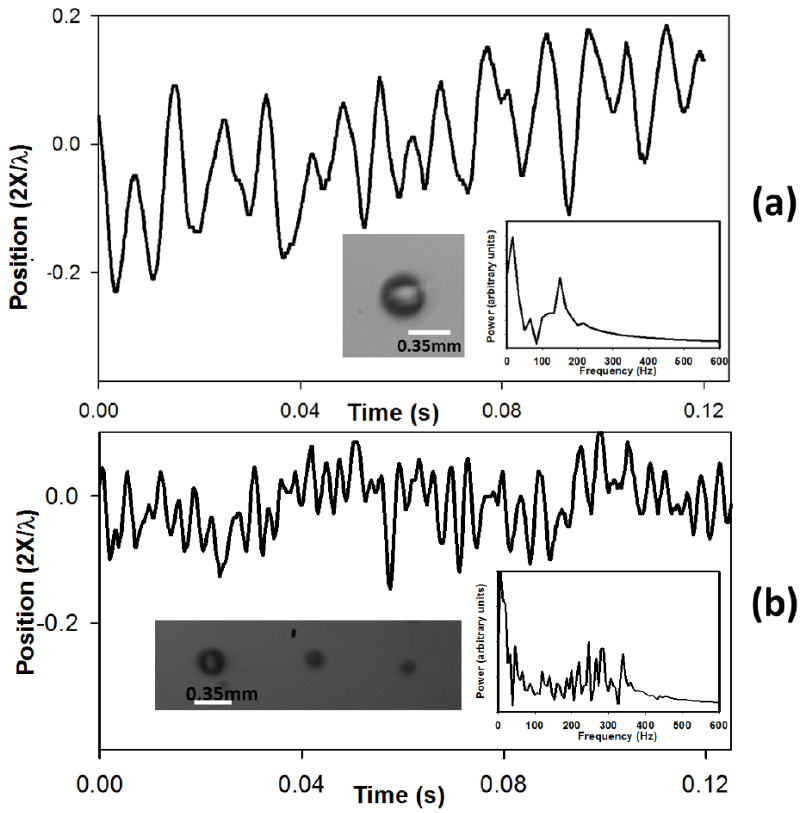
Figure 2. Measured position of ( a ) an isolated acoustic bubble and ( b ) an acoustic bubble in a self- organized chain of bubbles as a function of time. The position is that of the center of mass of the bubble along the direction of the standing wave normalized to half a wavelength, λ , of the acoustic wave. The power spectrum calculated from the Fourier transform of the normalized time-autocorrelation function of the position of the bubble (lower right inset of ( a , b )). Lower left inset of ( a , b ): snapshot of the oscillating bubble(s).